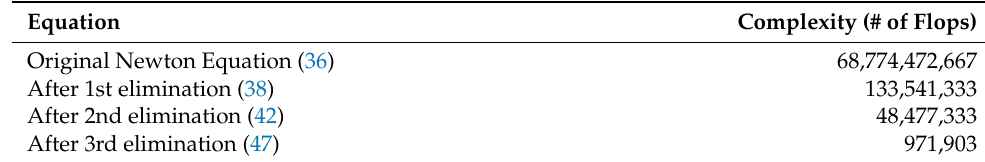
Table 5. Summary of complexity to solve Newton equation for SC35.